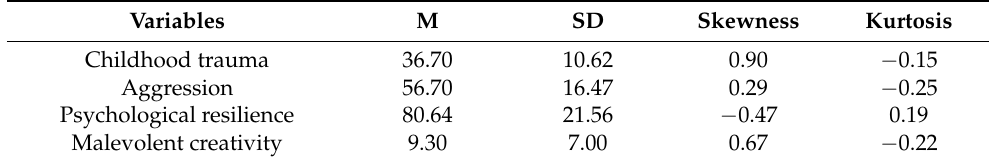
Table 1. Descriptive statistical results of study